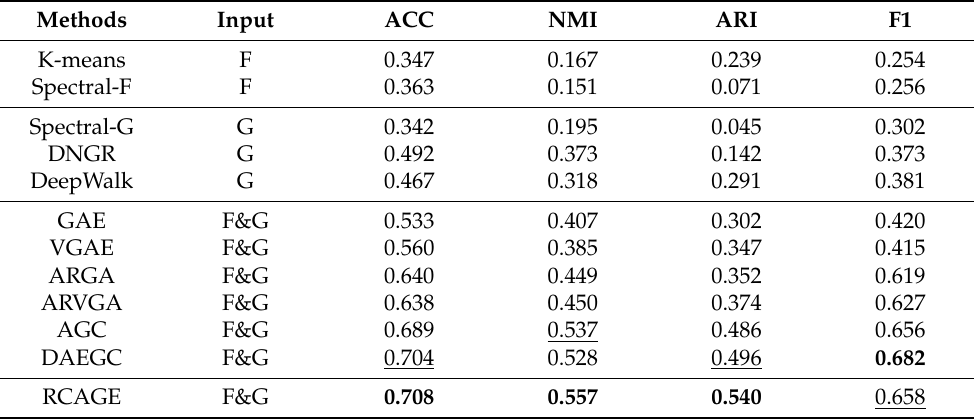
Table 2. Node-clustering performance on